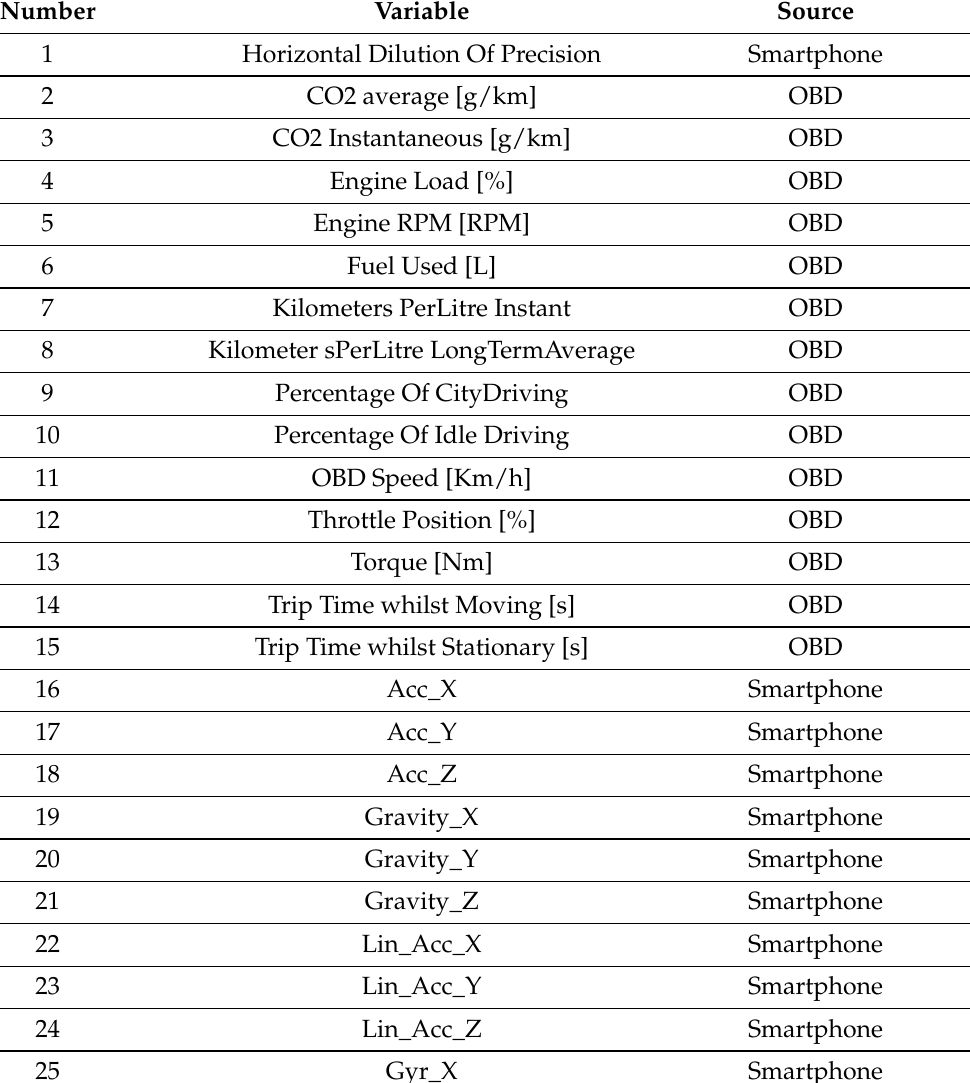
Table A1. Raw data variables used in